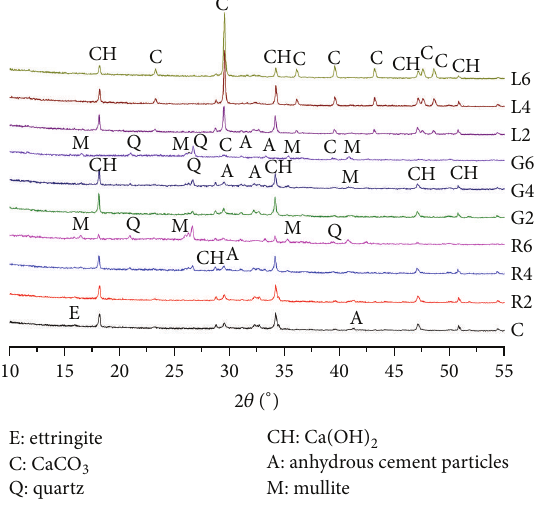
Figure 7: XRD patterns of specimens at 7d.